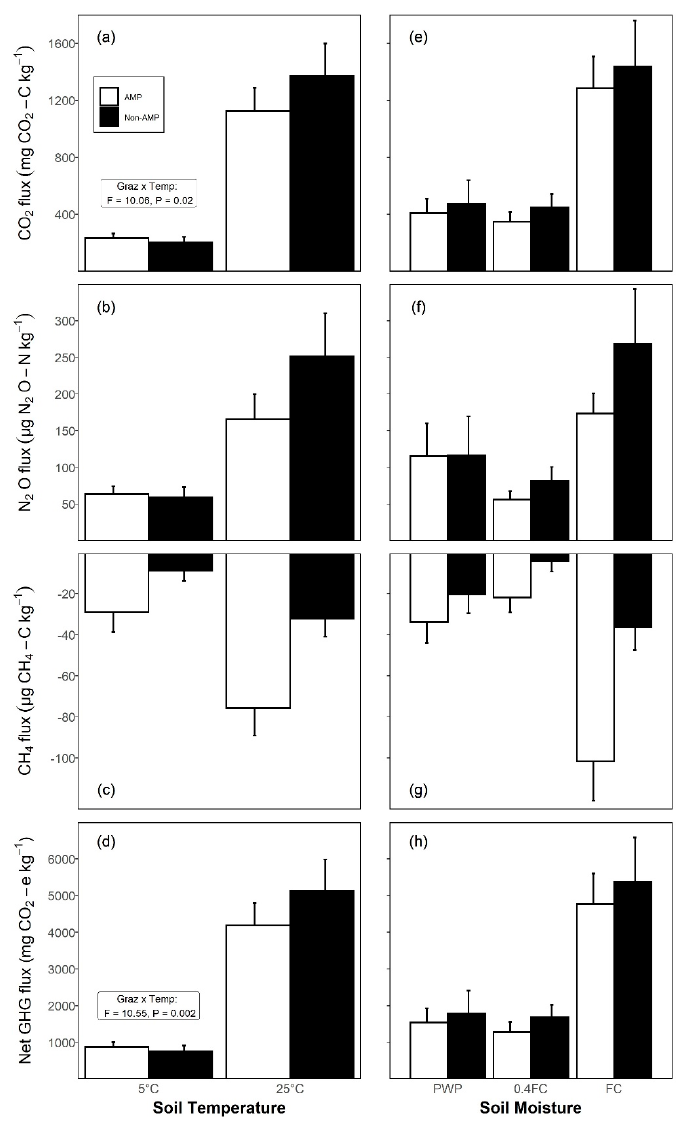
Figure 1. Left panels show effects of grazing and temperature on total fluxes of GHGs (mean ± SE) in a 102-day incubation experiment on soils from either adaptive multi-paddock (AMP) or conventional (non-AMP) grazing systems: ( a ) CO 2 -C, ( b ) N 2 O-N, ( c ) CH 4 -C, and ( d ) net GHG flux. Right panels show effects of grazing and moisture on total flux of GHGs: ( e ) CO 2 -C, ( f ) N 2 O-N, ( g ) CH 4 -C, and ( h ) net GHG flux. Negative values show the consumption of CH 4 in the soil. Statistics in the inset box show an interaction between grazing and temperature on ( a ) CO 2 flux and ( d ) net GHG flux ( p < 0.05). Cumulative fluxes of N 2 O during the incubation period were independent of grazing ( p ≥ 0.58), but remained strongly influenced by soil temperature and moisture ( p < 0.001, Table 1). Soils at 25